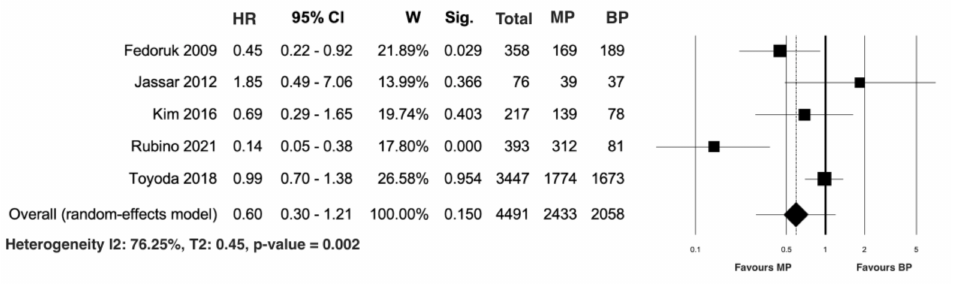
Figure 8. Forest plot for prosthesis reinfection. No statistical differences were observed between the MP and BP groups. Abbreviations: HR, hazard ratio; CI, confidence interval; W, weight; MP, mechanical prosthesis; and BP, biological